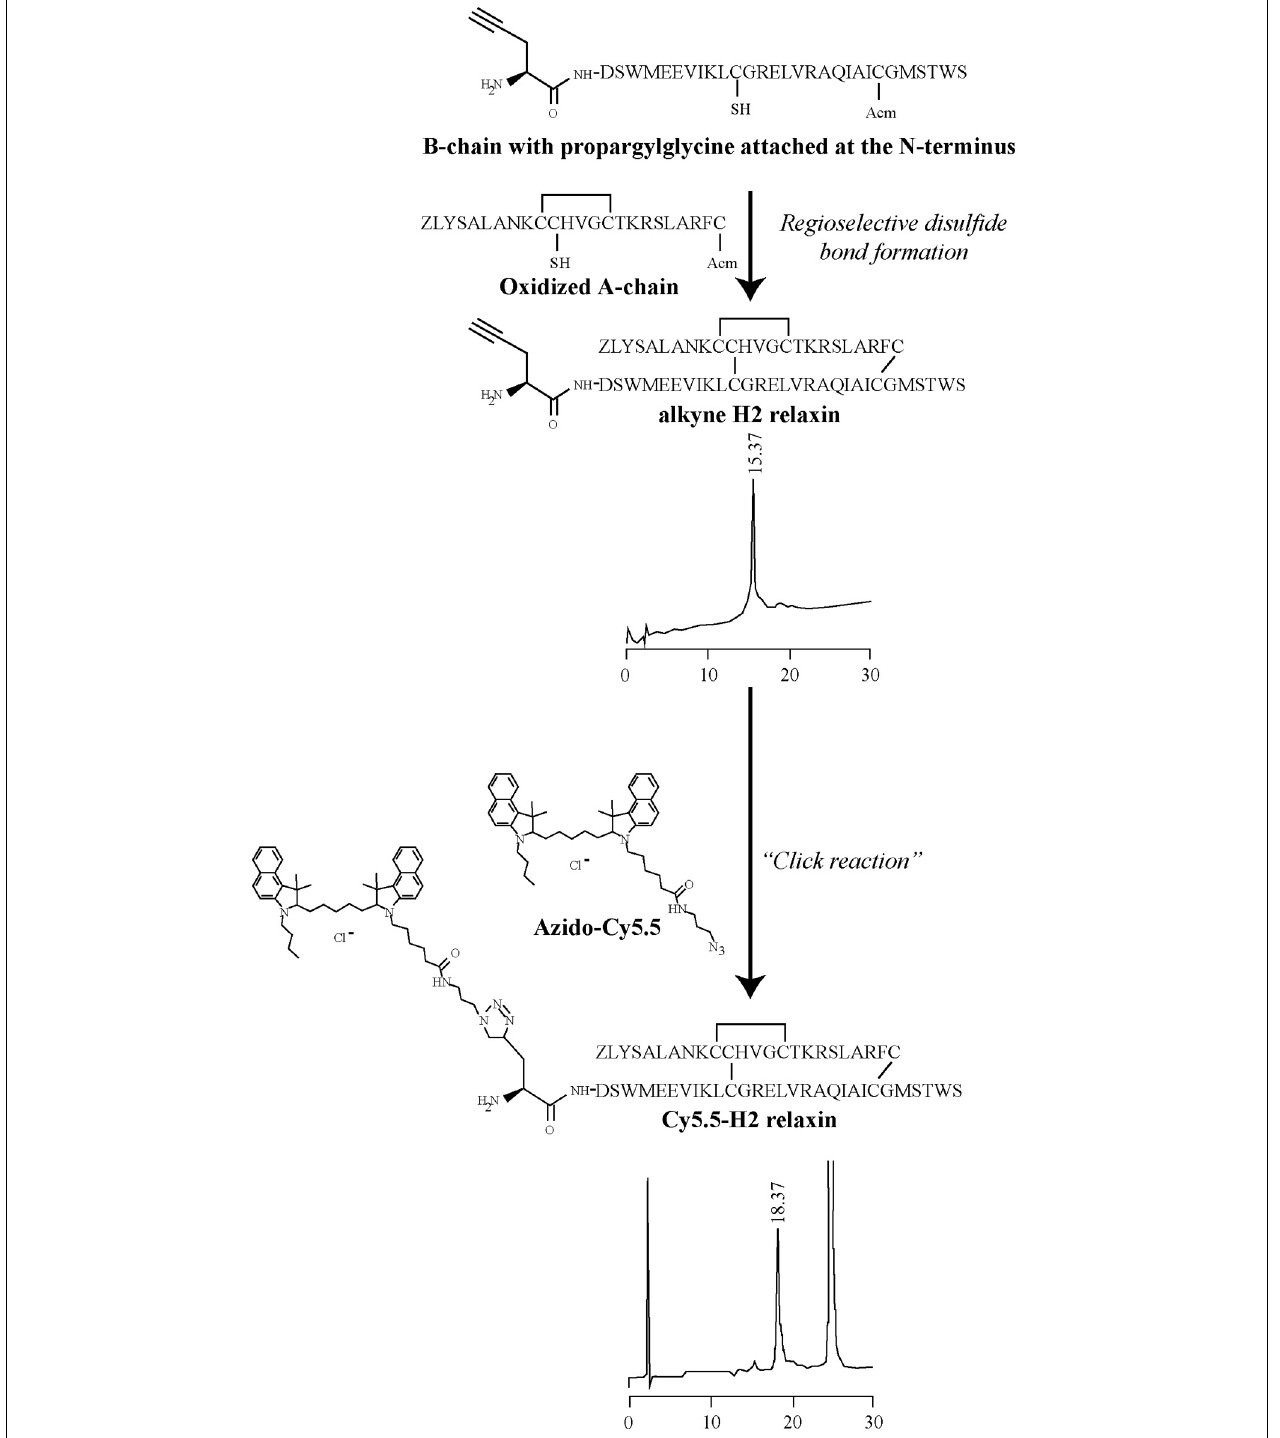
FIGURE 2 | General schematic representation of the formation of the Cy5.5 analogs. In step 1, an Fmoc-L-propargylglycine residue with an alkyne moiety was attached at the N-terminus of the B-chain on solid phase and then cleaved from the resin. In step 2, the propargylglycine B-chain was combined with the A-chain, together with the formation of the interdisulfide bonds to give the alkyne product. In step 3, under a copper-catalyzed